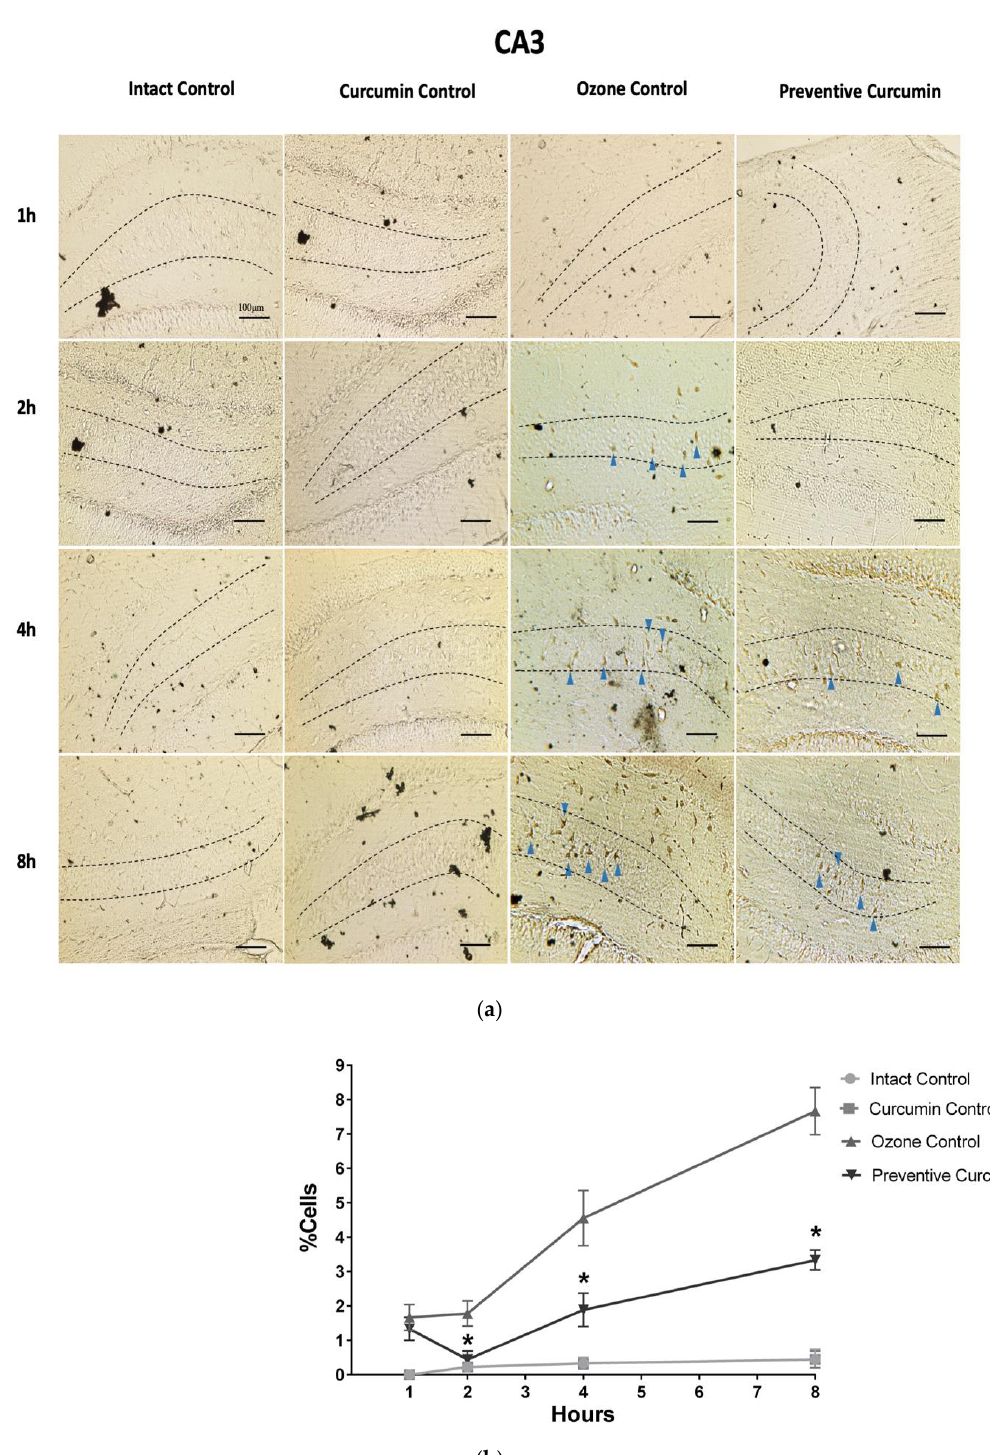
Figure 2. Effect of CUR against hippocampal neurodegeneration after short-term O 3 exposure (Table S2). CA3 region was evaluated by a modified silver technique (de Olmos stain). ( a ) This panel shows representative images of tissue sections at different exposure times in experimental groups ( n = 5) showing positive cells (dark brown), indicated with blue arrowheads, dashed lines indicate the CA3 area, ( b ) The graph illustrates the comparison of the degenerative cell percentage at each exposure time in experimental groups; results are expressed mean values ± SEM and the asterisk indicates a statistical difference between the preventive curcumin and ozone control groups ( p < 0.05) at 2, 4, and 8 h. Data of intact control and curcumin control groups are overlapped in the two lines at the